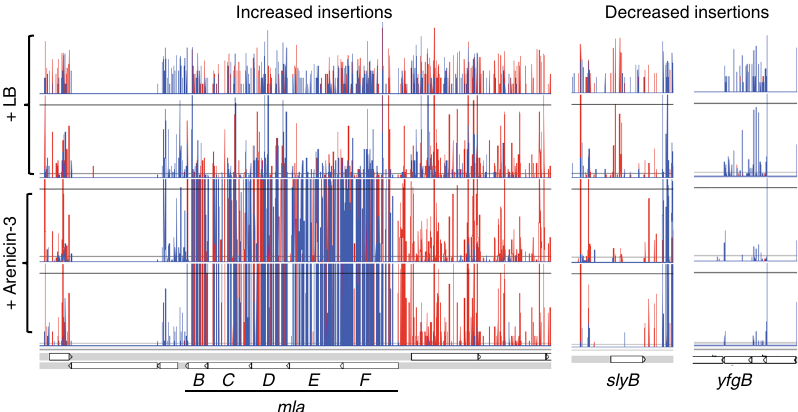
Fig. 4 TraDIS reads representing transposon insertions across the mla operon (B-F), slyB and yfgB in UPEC. The arenicin-3-treated library is represented by the bottom two rows and the controls with LB only, the top two rows. Insertion positions of Tn 5 mutations at each bp are represented by vertical lines, the depth represented by the height of the line and the direction of insertion, the color (forward and reverse are red and blue, respectively) across the entire mla operon. Note, mlaA is not shown here as it is located separately but also displayed the same pattern